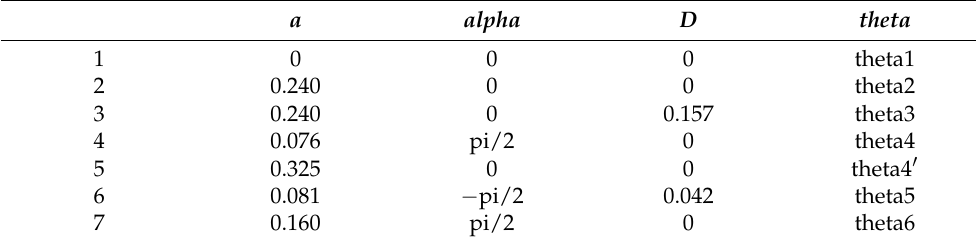
Table 4. Polyarticulated arm mDH